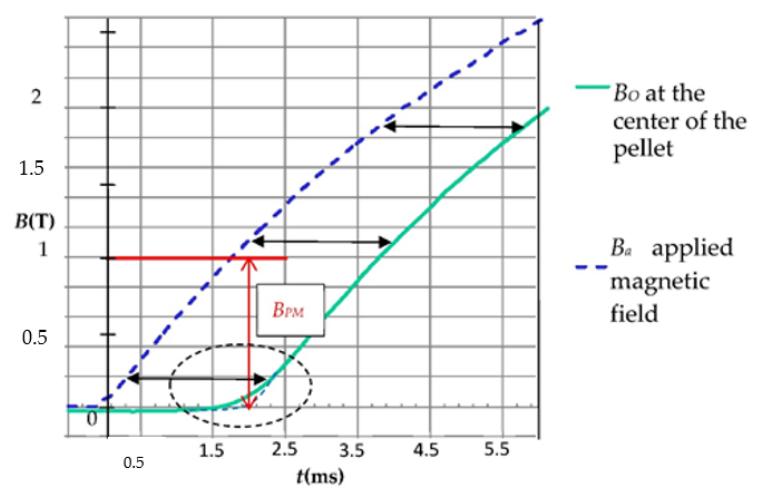
Figure 11. Applied magnetic field Ba and measured magnetic field Bo at the center of the HTS bulk versus time.